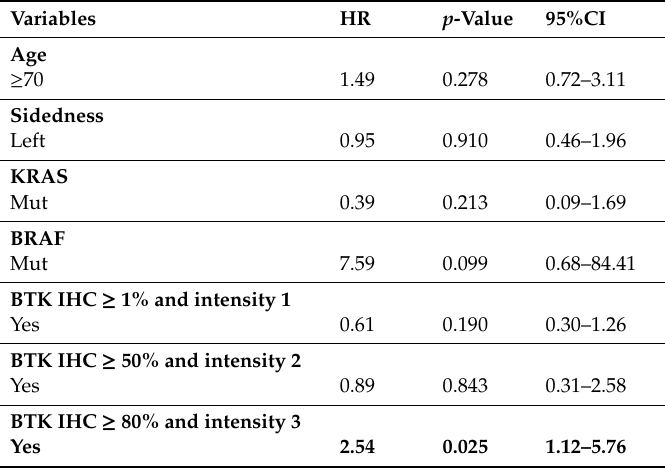
Figure 3. Kaplan–Meier disease-free survival (DFS). Figure 3. Kaplan – Meier disease-free survival (DFS). Table 5. Univariate analysis of overall survival Table 5. Univariate analysis of overall survival (OS).